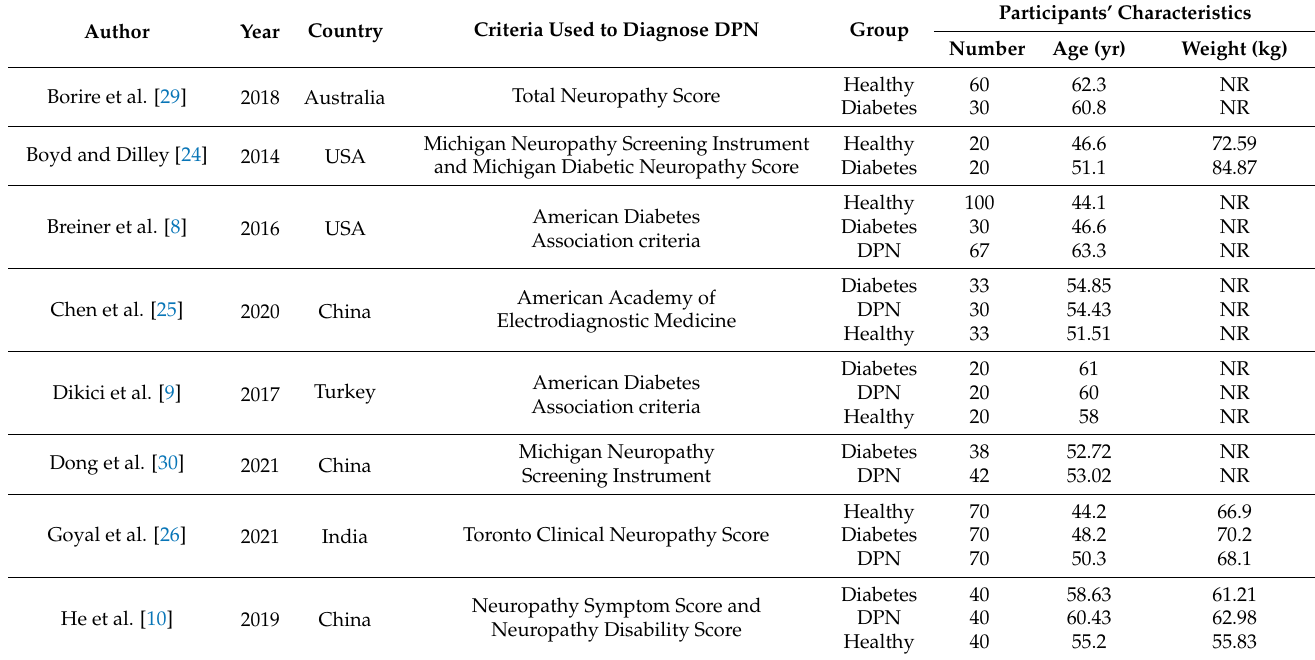
Table 1. Characteristics of the 16 included studies for the meta-analysis of pooled effect size and mean difference of tibial nerve cross-sectional area in diabetic patients with diabetic neuropathy, diabetic patients, and healthy controls. Studies are listed in alphabetical